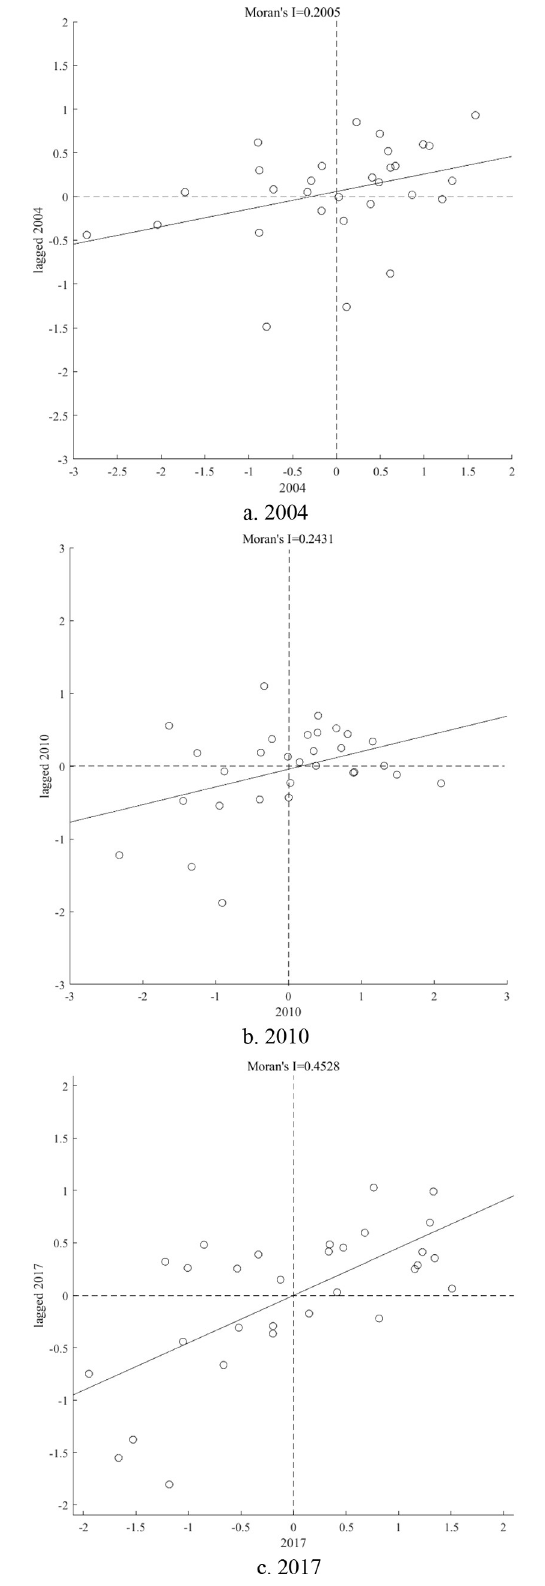
Fig 1. Local Moran scatter plots of China’s provincial GTFP in 2004, 2010 and 2017. https://doi.org/10.1371/journal.pone.0250798.g001 PLOS ONE | https://doi.org/10.1371/journal.pone.0250798 April 30,